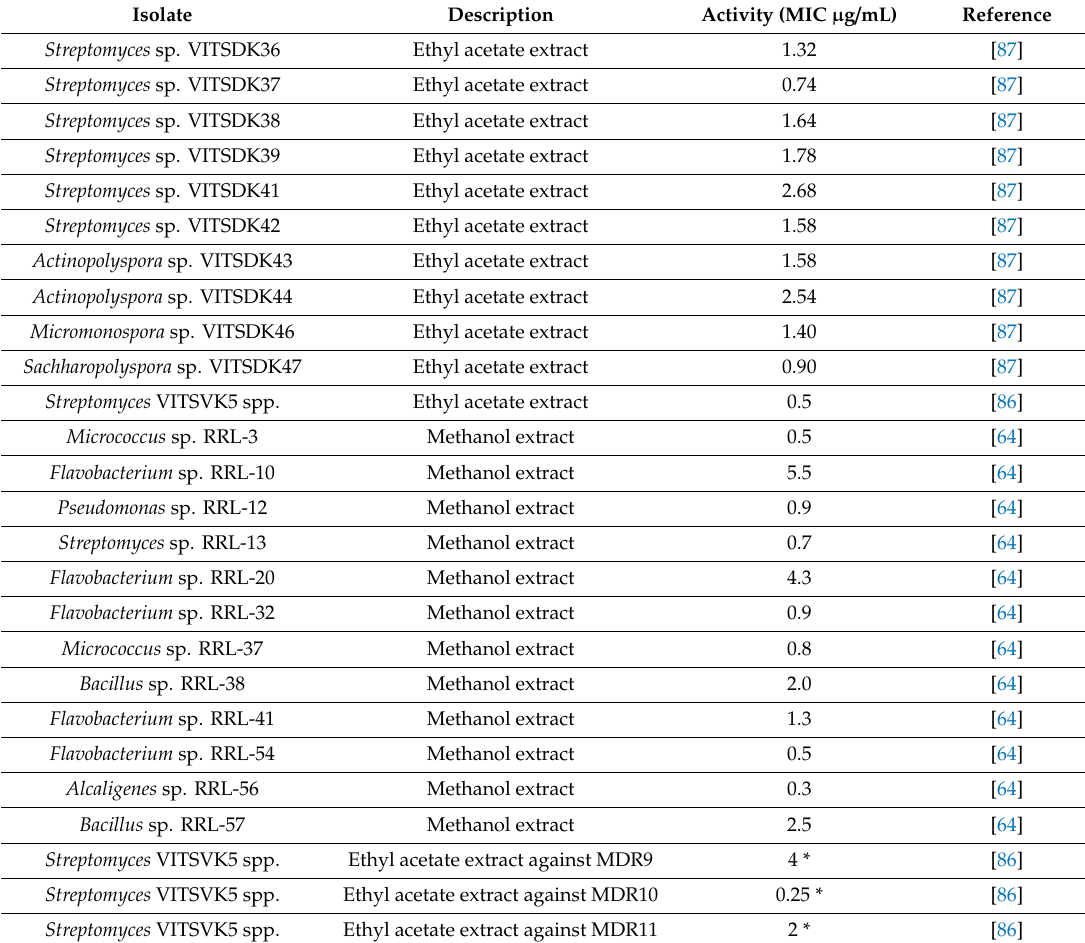
Table2. Antifungalactivityofextractsfrommarineactinomycetesandotherbacteriaagainst A.fumigatus or MDR A.